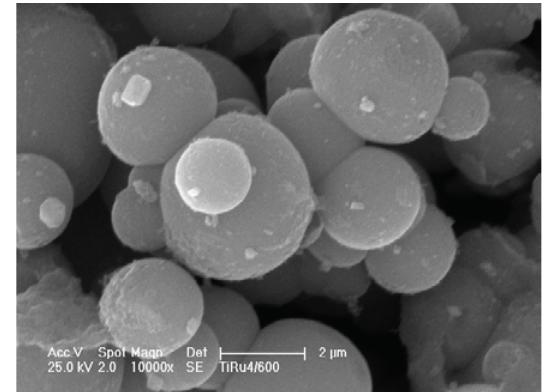
Figure 4. SEM micrograph of TiRu4_600 Figure 5. HRTEM micrographs of (a), (b) TiRu3_600, (c) RuO 2 phase, (d) anatase phase. Figure 6. Electron diffraction pattern of TiRu3_600.